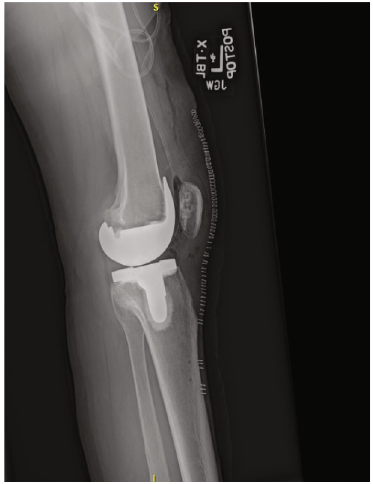
Figure 5: Postop lateral TKA